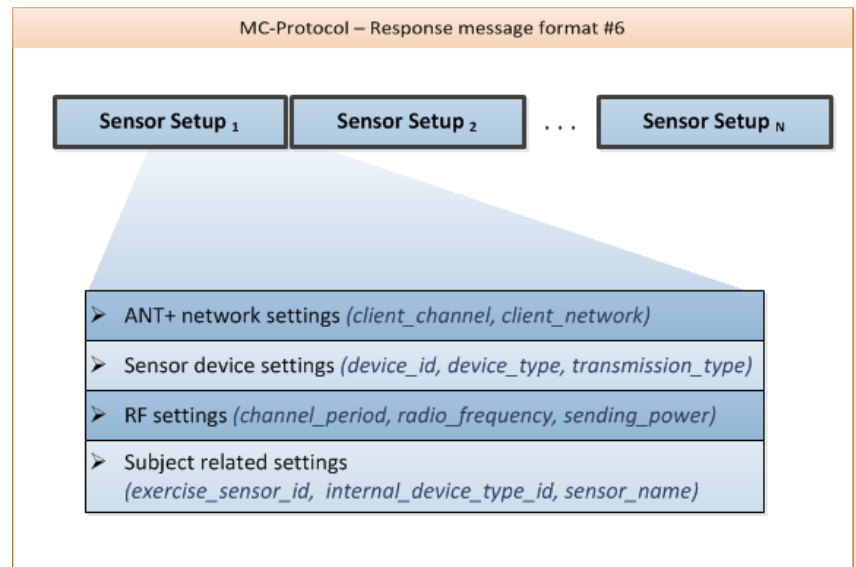
Figure 4. Response message format